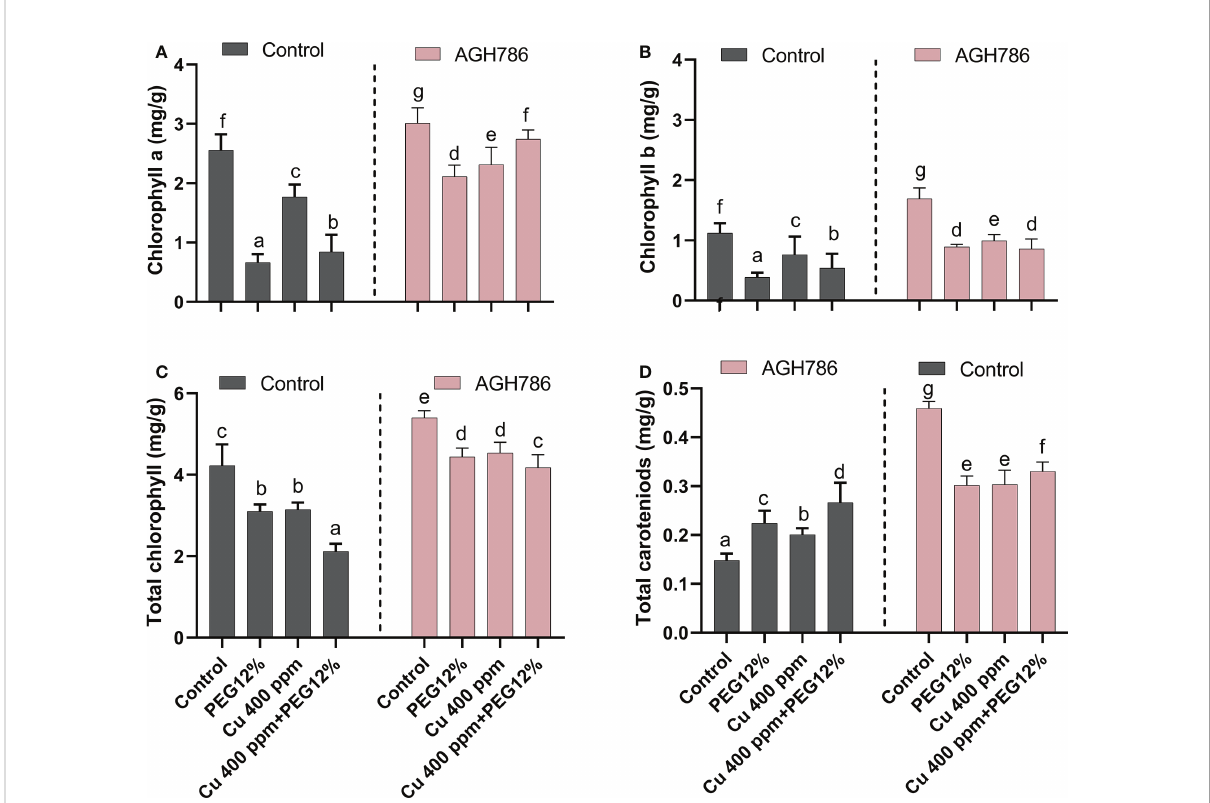
FIGURE 4 Effect of P. spadiceum AGH786 on the photosynthetic potential of S. lycopersicum L. under heavy metal (Cu) toxicity and drought stress (12% PEG). (A) Chlorophyll a, (B) chlorophyll b, (C) total chlorophyll, and (D) total carotenoids. Data represent the mean with standard error, and letters represent the signi fi cant difference (p <